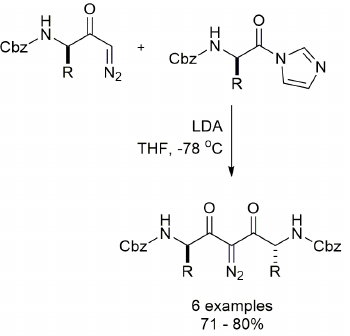
Figure 51 - The coupling reaction between acyl imidazolide and α-diazoketones.